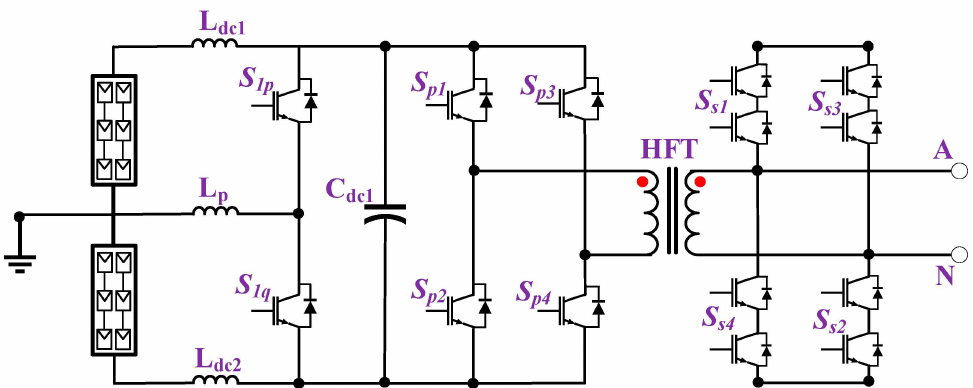
Figure 10. A single submodule of a modified CHB converter cycloconverter